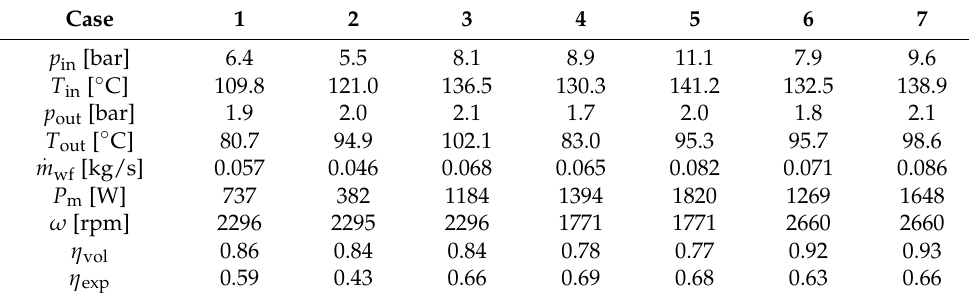
Table 2. Experimental database for model validation